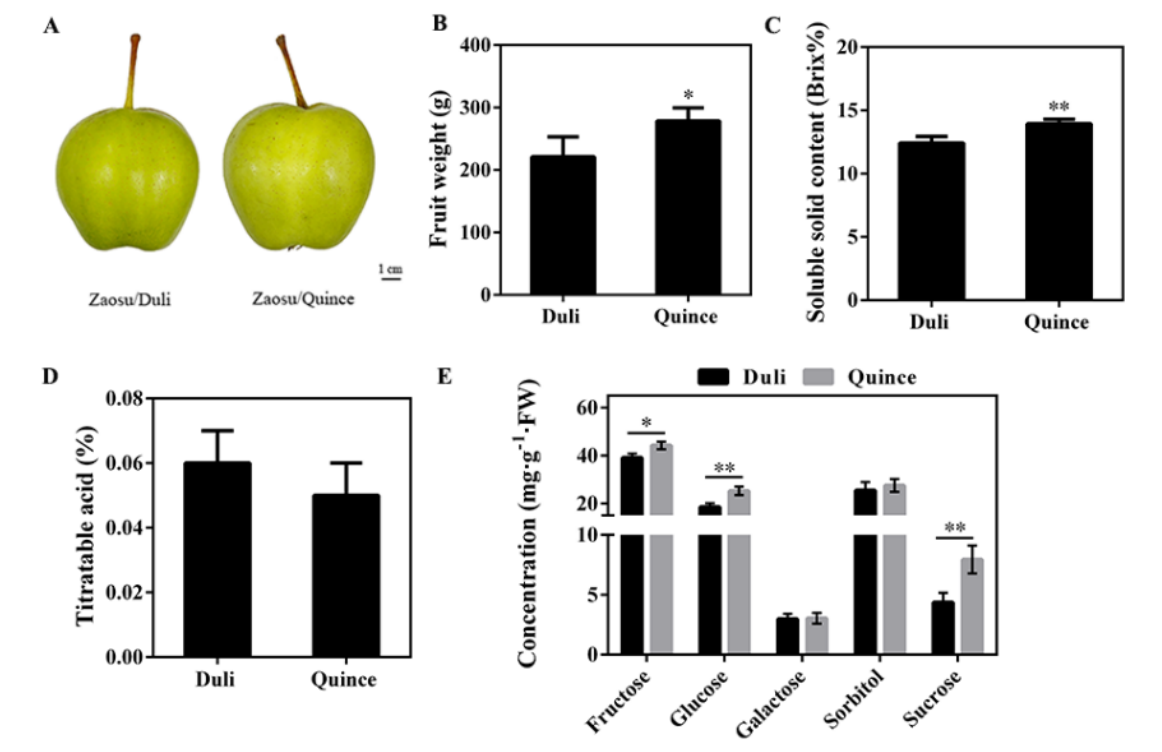
Figure 1. The fruit quality of ‘Zaosu’ pear grafted on ‘Yunnan’ quince (Z/Q) and ‘Duli’ (Z/D). ( A ) Z/Q and Z/D fruits at 110 (DAFB). ( B ) Fruit weight. ( C ) Soluble solid content. ( D ) Titratable acid. ( E ) Concentrations of fructose, glucose, galactose, sorbitol, and sucrose in mature Z/Q and Z/D fruits. The data represent mean values ± SDs. Asterisks indicate significant differences as determined by Student’s t tests (* p < 0.05; ** p < 0.01).